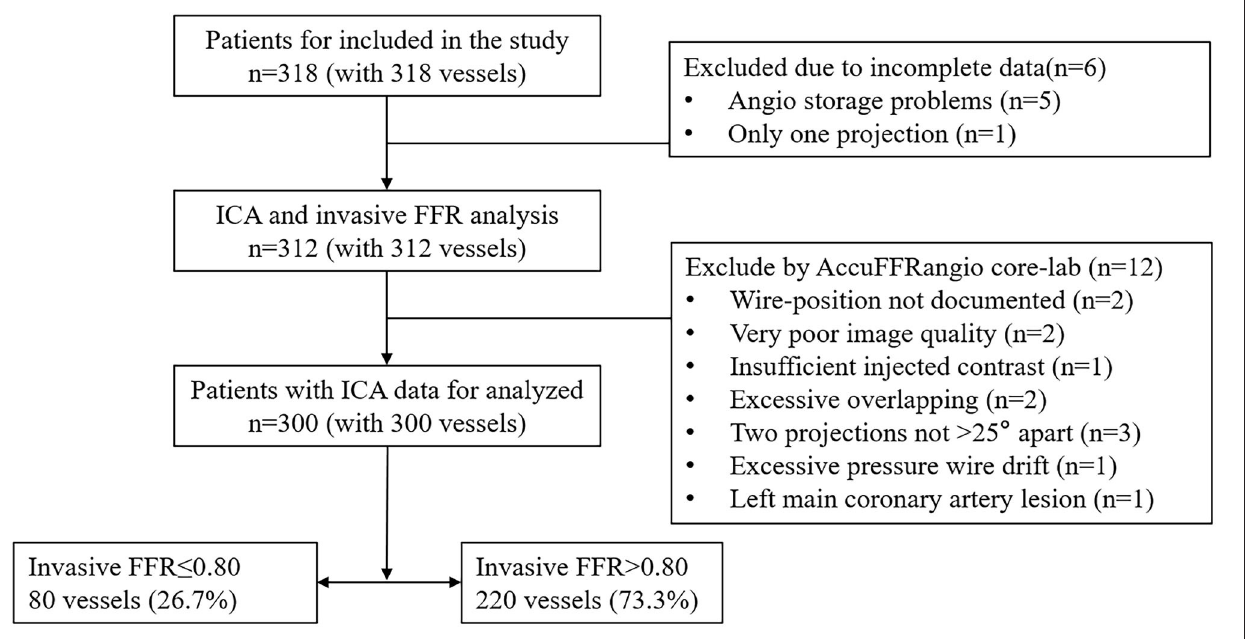
FIGURE 2 | Study enrollment flow